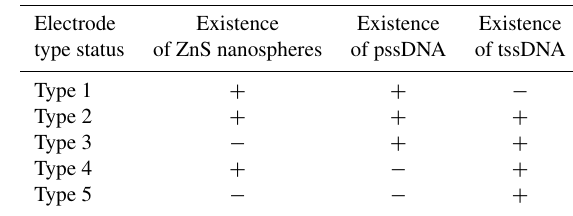
Table 1. Various statuses of used electrodes in electrochemical ex-